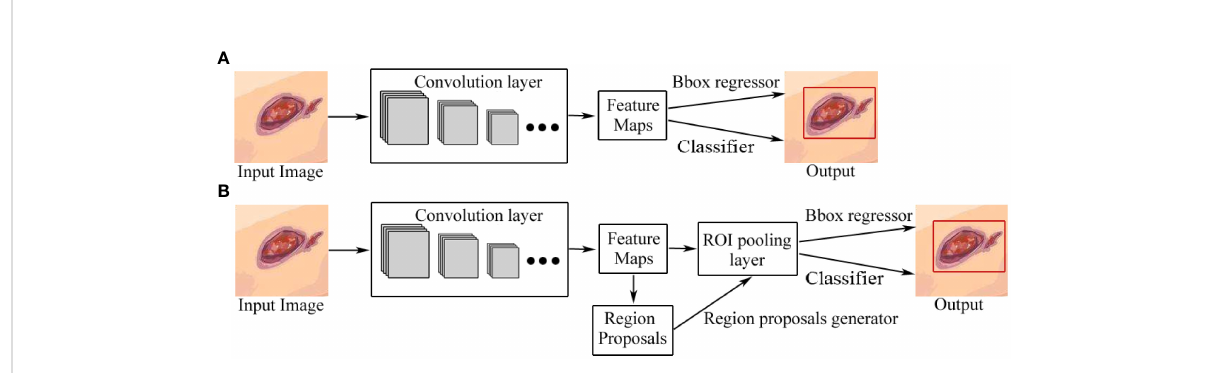
FIGURE 5 Two categories of object detection based on deep learning. (A) One-stage detection architecture. (B) Two-stage detection architecture. The difference between one-stage and two-stage models is that a two-stage model has a region-proposal process. Bbox regressor refers to the bounding box